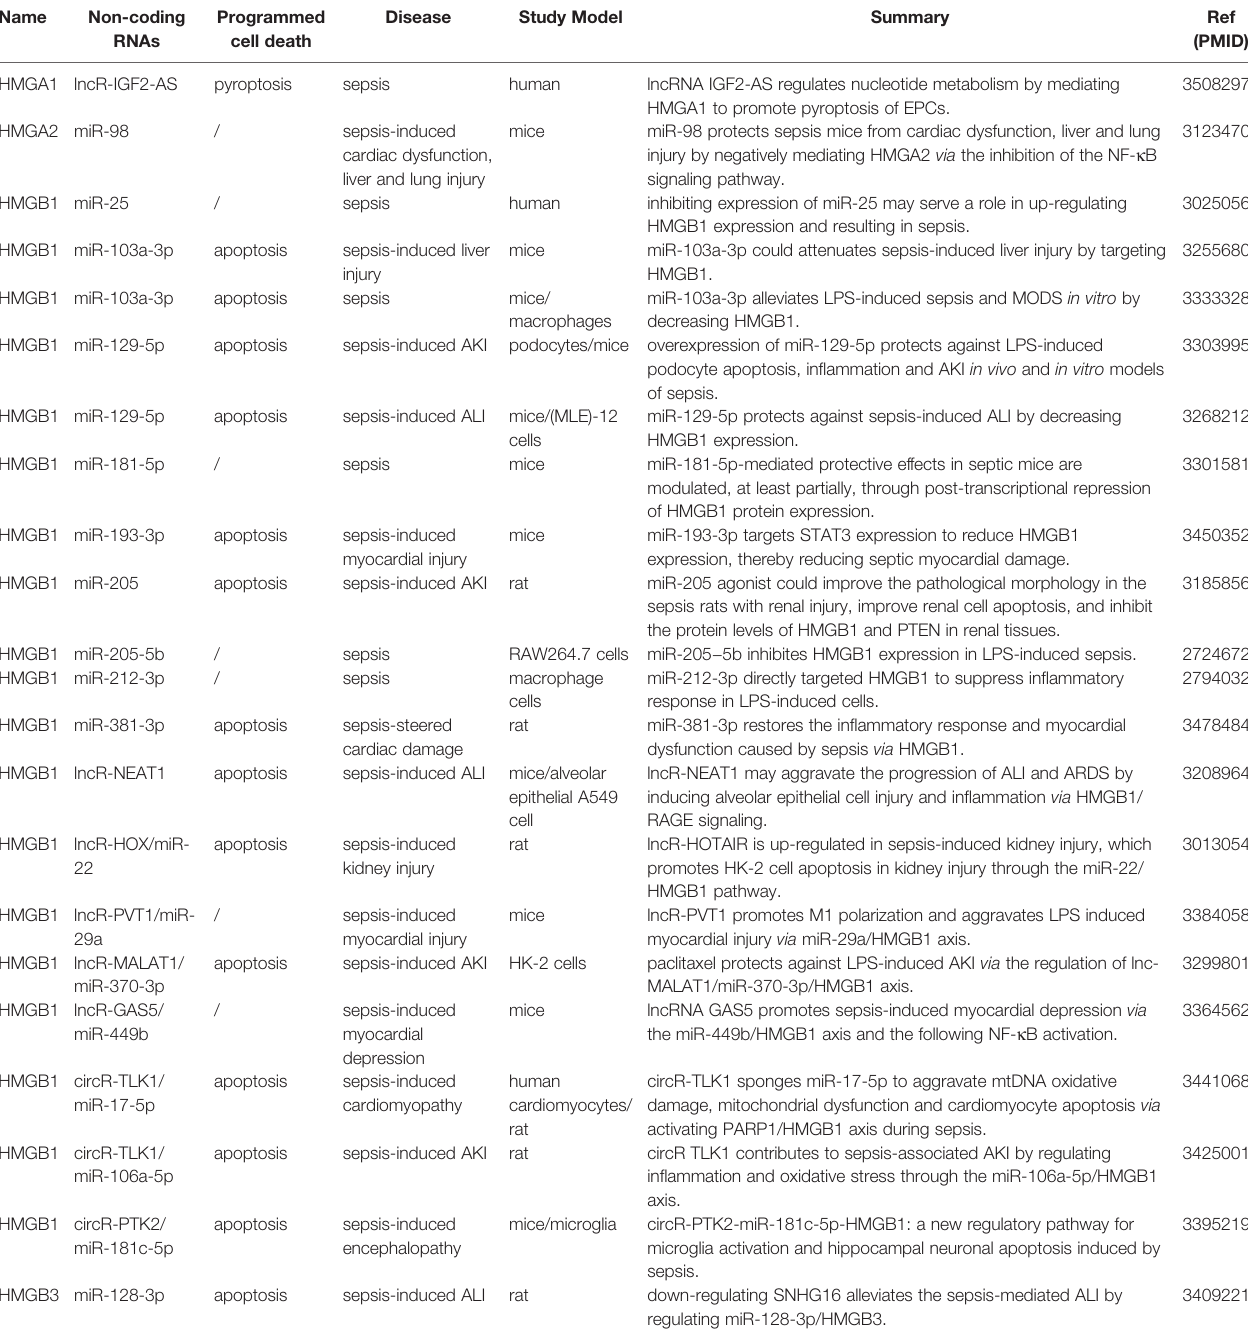
TABLE 1 | Non-coding RNAs in HMGs and sepsis. Reference given as PMID. Non-coding